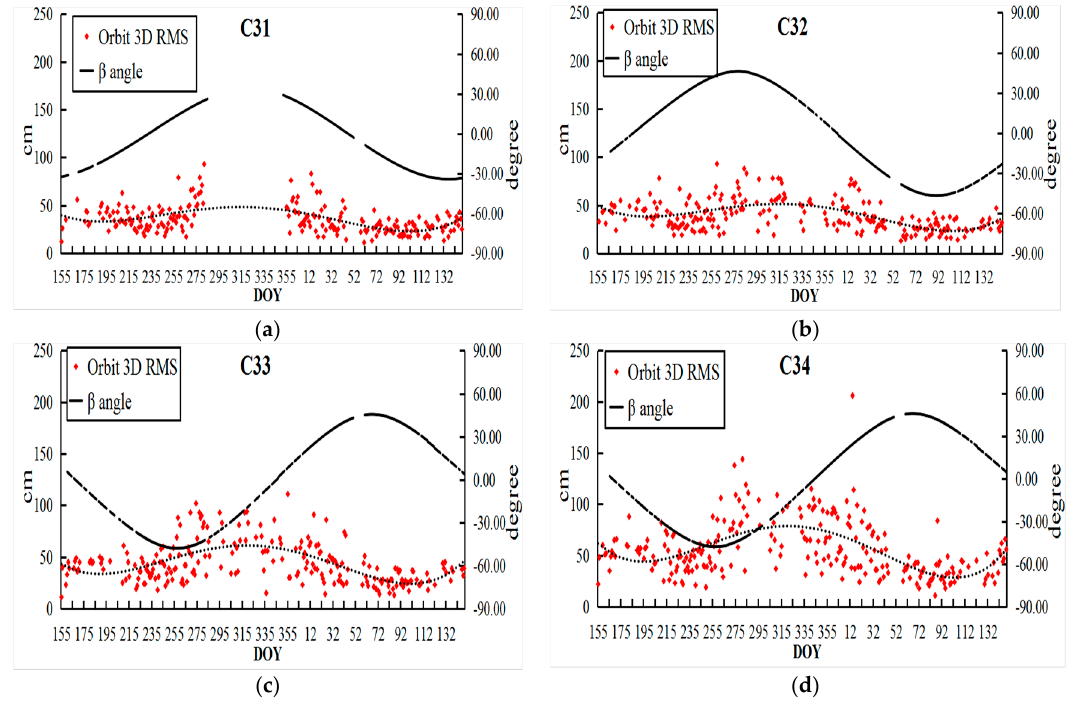
Figure 10. The 3D RMS of BDS-3 one-day overlapping arc errors based on SS (( a ) C31; ( b ) C32; ( c ) C33; and ( d ) C34).